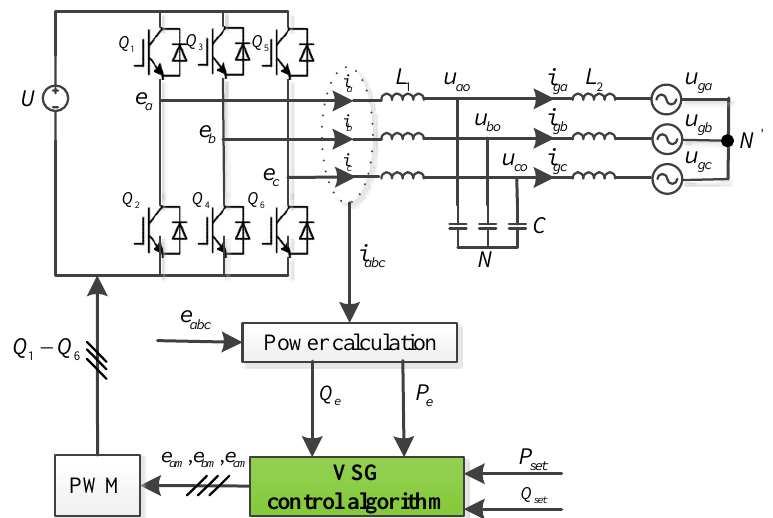
Figure 10. Main circuit topology of DC/AC with VSG control algorithm.